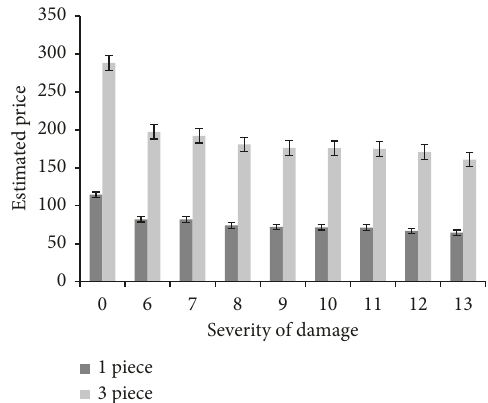
Figure 3: Estimated prices of 1 and 3 apples. Error bar represents a 95% confidence